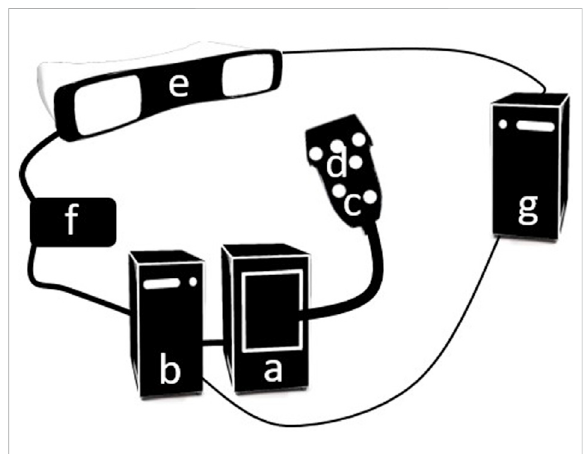
FIGURE 1 An overview of the fast FVUS system. (A) The Verasonics V1 US machine. (B) The Verasonics V1 control PC. (C) US transducer. (D) Optical marker. (E) PST optical tracking system. (F) Synchronization block. (G) Processing workstation